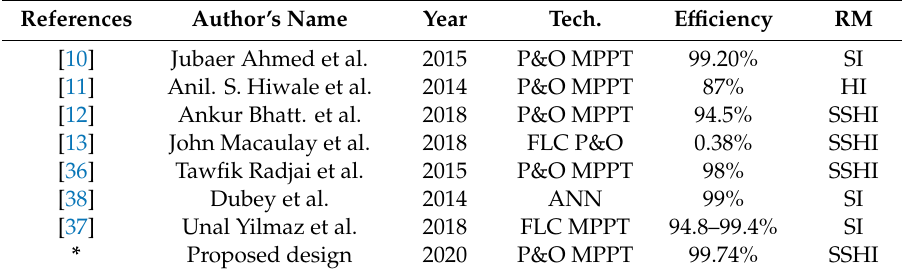
Table 3. Comparative analysis of di ff erent MPPT technique e ffi